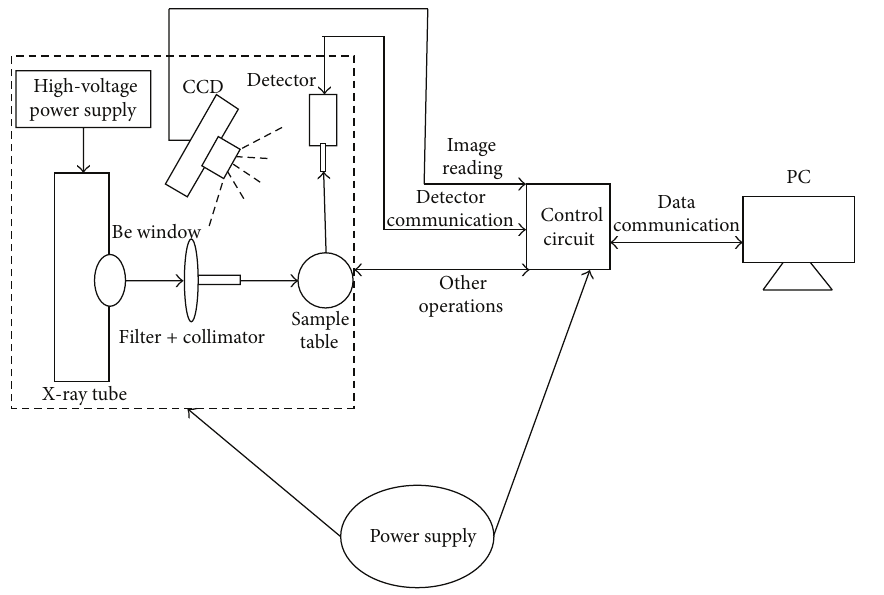
Figure 1: Structural diagram of the EDXRF